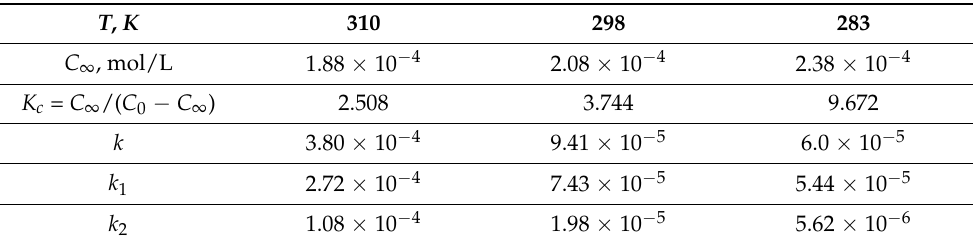
Table 1. Kinetic parameters of the adsorption and desorption of fluoride ions from solution by the bacterial cellulose-based modified sorbent at different temperatures.